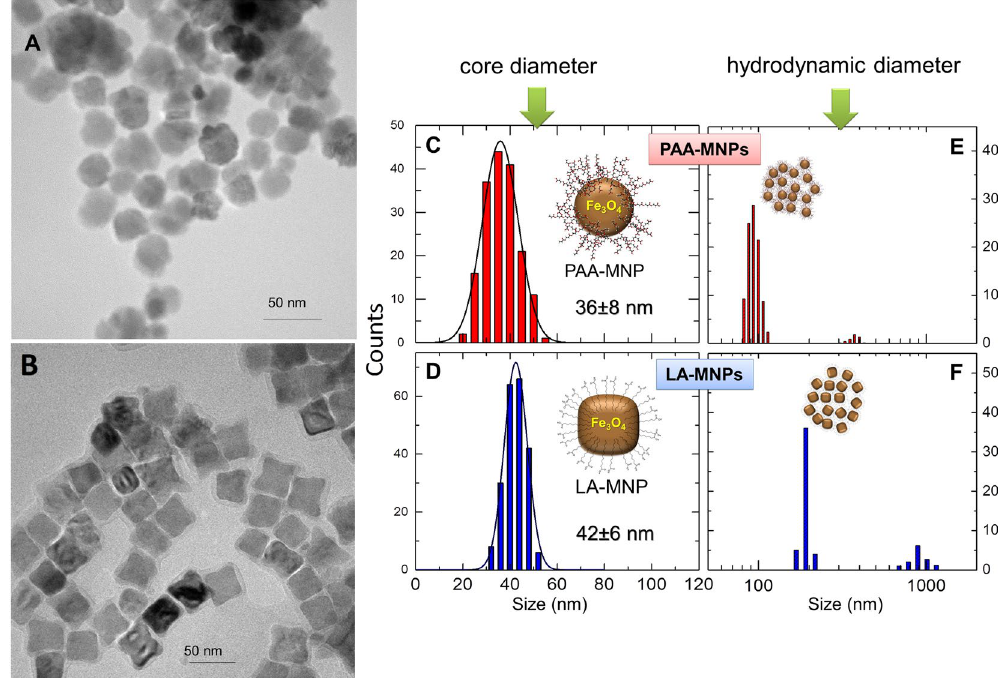
Figure 1. TEM images (left) of PAA-MNPs ( A ) and LA-MNPs ( B ), their histograms (right, C , D ) and hydrodynamic diameter ( E , F